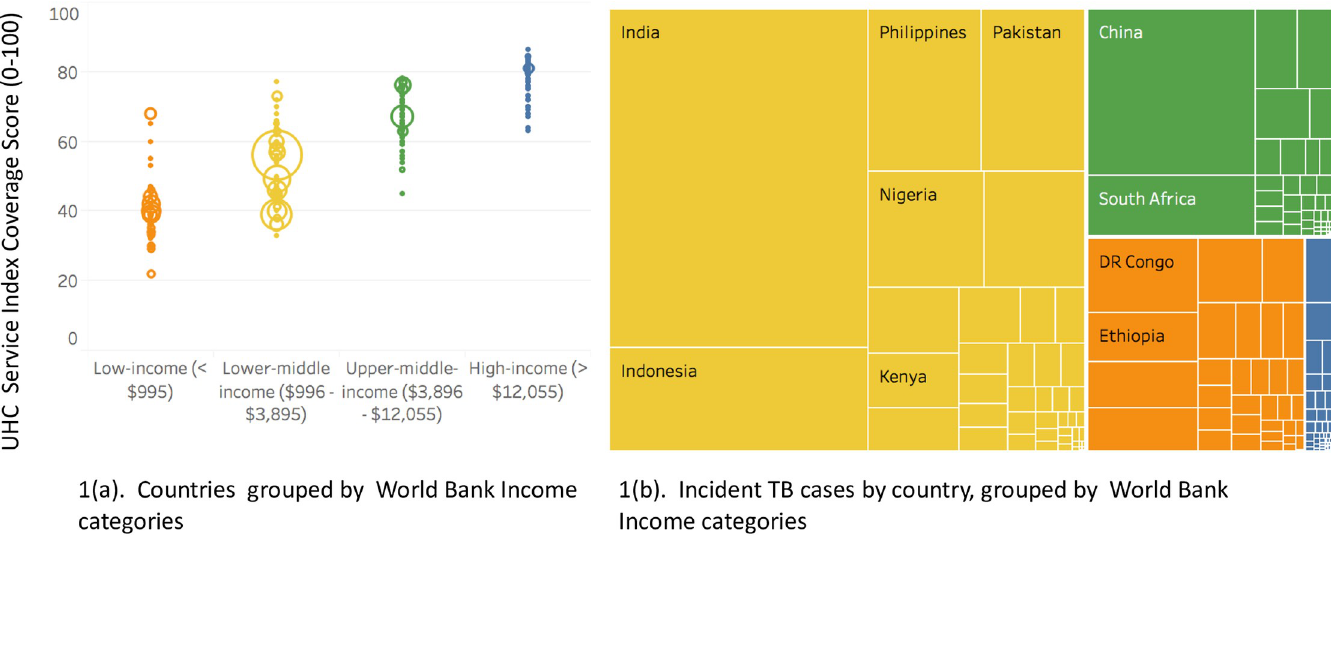
Fig 1. (a). UHC Service coverage index scores, stratified by World Bank country income categories and 1(b) TB burden delineated by absolute number of incident cases (2015) and World Bank country income categories.